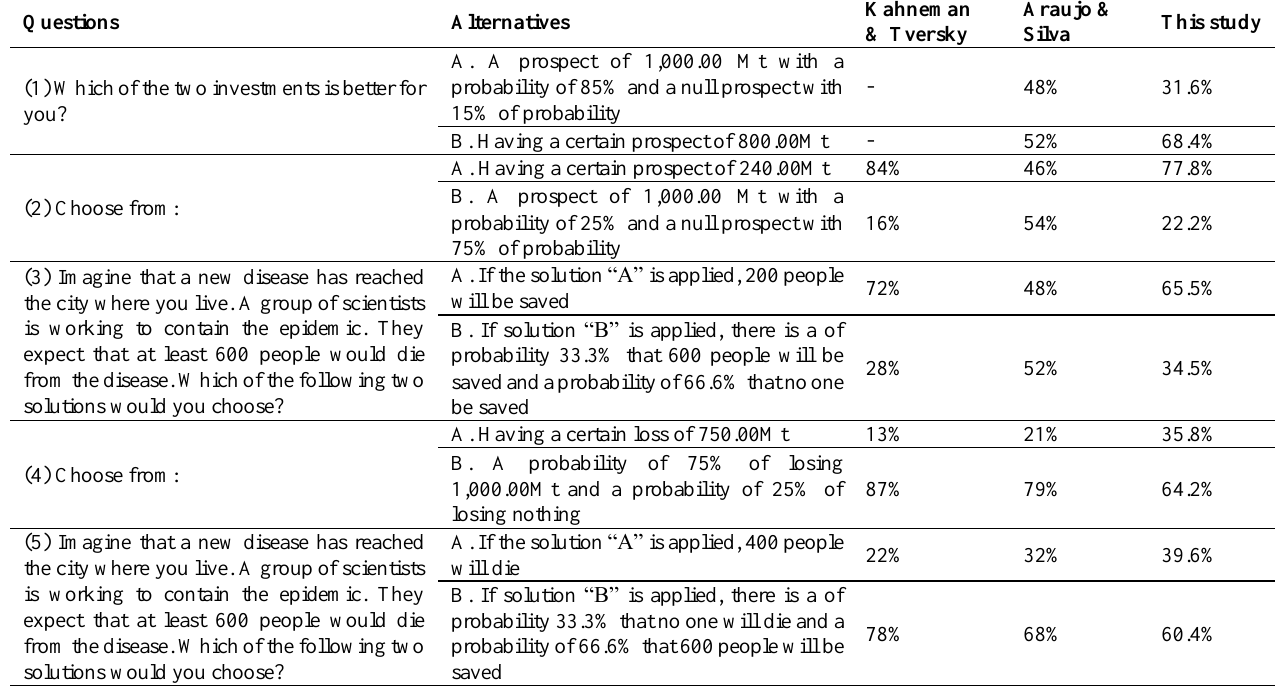
Table 5: Loss aversion